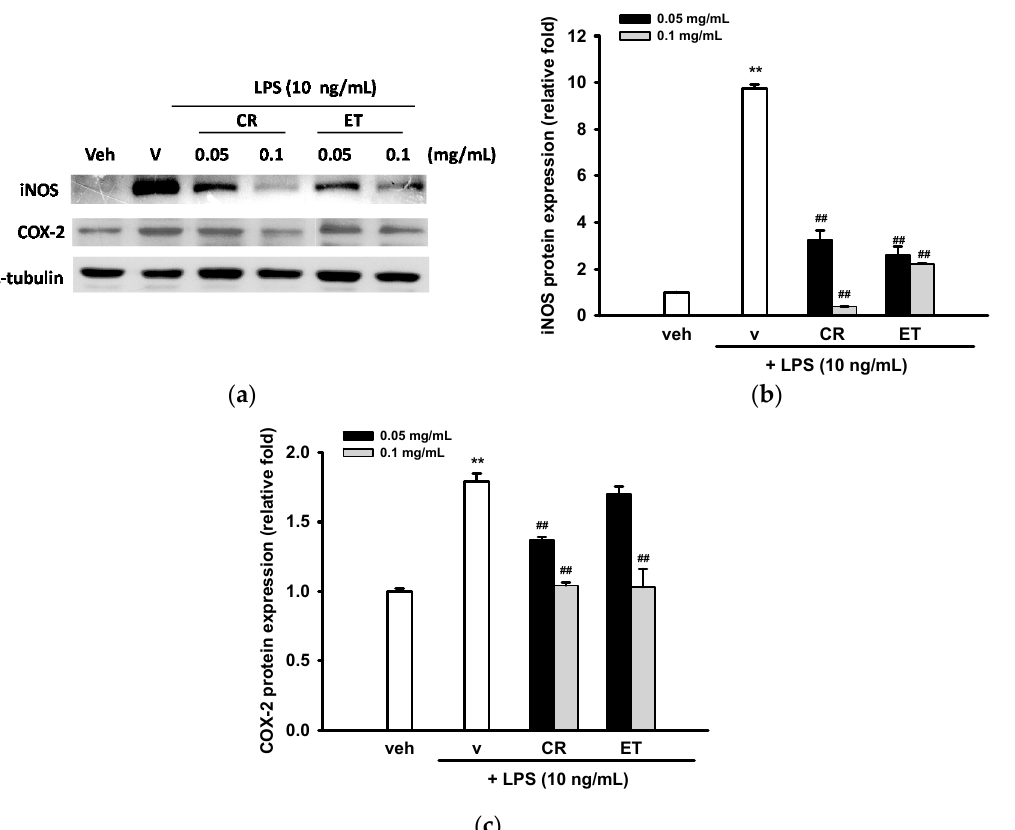
Figure 2. Effects of ethanol extracts of C. rutidosperma and E. thymifolia on iNOS and COX-2 expression in LPS-induced BV2 cells. ( a ) BV2 cells were cultured with indicated reagent in 6-well plates for 16 h and Western blotting of iNOS, COX-2 and α -tubulin were performed, as described in Materials and Methods. Representative blots from three independent experiments are shown; ( b , c ) Band intensities were quantified by ImageJ software and indicated as relative folds of iNOS/ α -tubulin and COX-2/ α -tubulin. Data are represented as the mean ± SD ( n = 3). Statistical differences are presented ** p < 0.01 compared with the vehicle control (without LPS) and ## p < 0.01 compared with the LPS-treated vehicle.